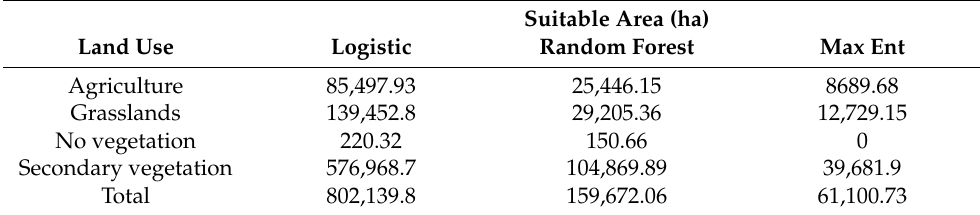
Table 9. Validation metrics used for comparison purposes. Table 10. Land suitability for the establishment of plus trees of P. oocarpa